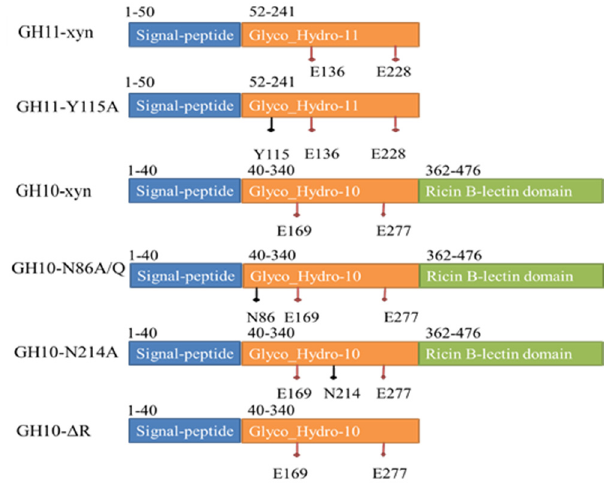
Figure 4. Schematic overviews of xylanases produced from Streptomyces L10608. GH11-xyn: GH11 family recombinant xylanase from Streptomyces L10608. GH11-Y115A: binding site on − 2 site-directed mutagenesis of GH11 xylanase. GH10-xyn: GH10 family recombinant xylanase from Streptomyces L10608. GH10-N86A/Q: binding site on − 2 site-directed mutagenesis of GH10 xylanase. GH10-N214A: binding site on +2 site-directed mutagenesis of GH10 xylanase. GH10- Δ R: Remove Ricin B-lectin domain of GH10 xylanase.